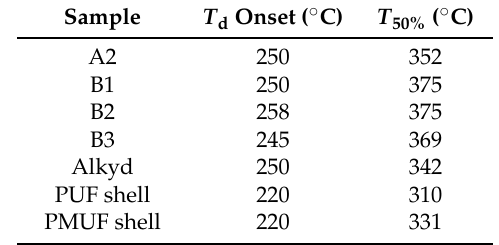
Table 4. TGA data of microcapsules, core and